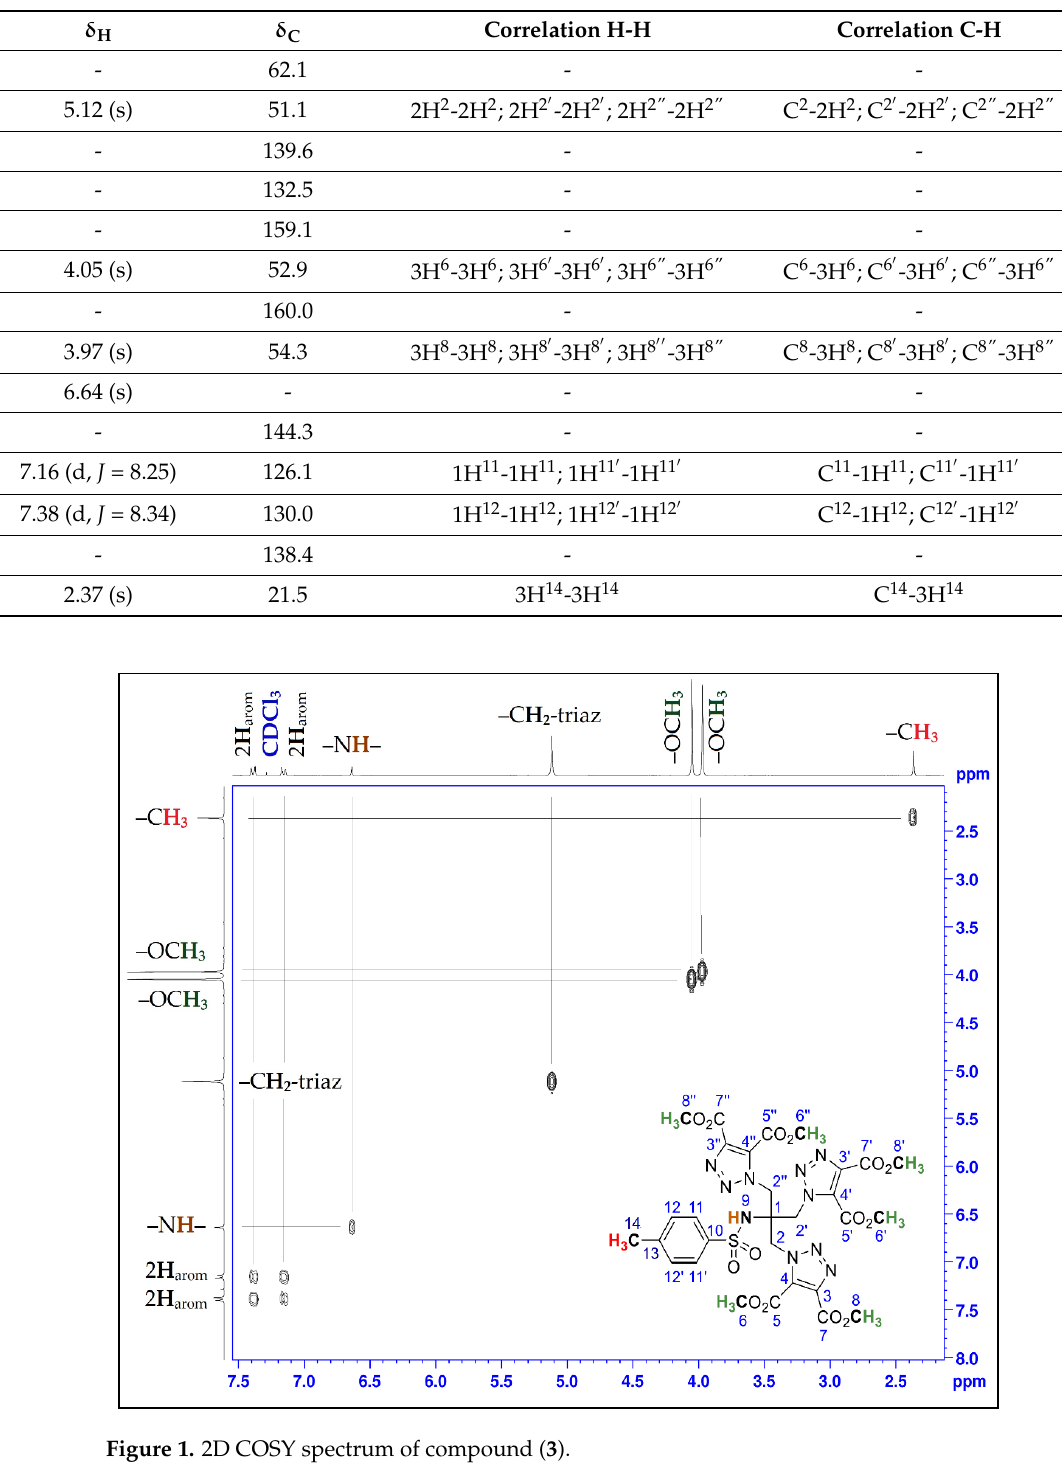
Table 1. 1 H (300 MHz) and 13 C (75 MHz) NMR spectral data for compound ( 3 ) in CDCl 3 , including results obtained by homonuclear 2D shift-correlated and heteronuclear 2D shift-correlated HMBC. Chemical shifts ( δ in ppm) and coupling constants ( J in Hz).